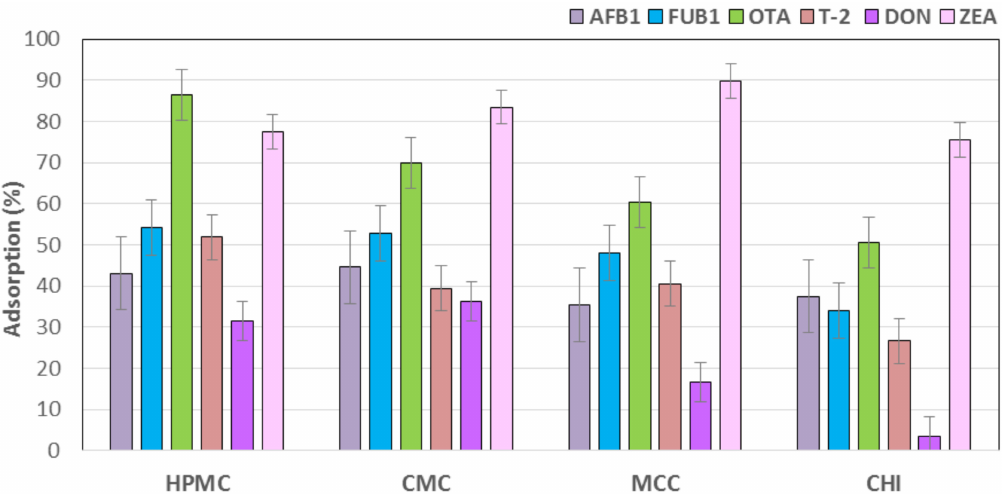
Figure 1. Percentage of adsorption of multiple mycotoxins on several adsorbents. Bars are the mean values. Error bars displays an interval around each mean, which are based on Fisher’s least significant difference (LSD)